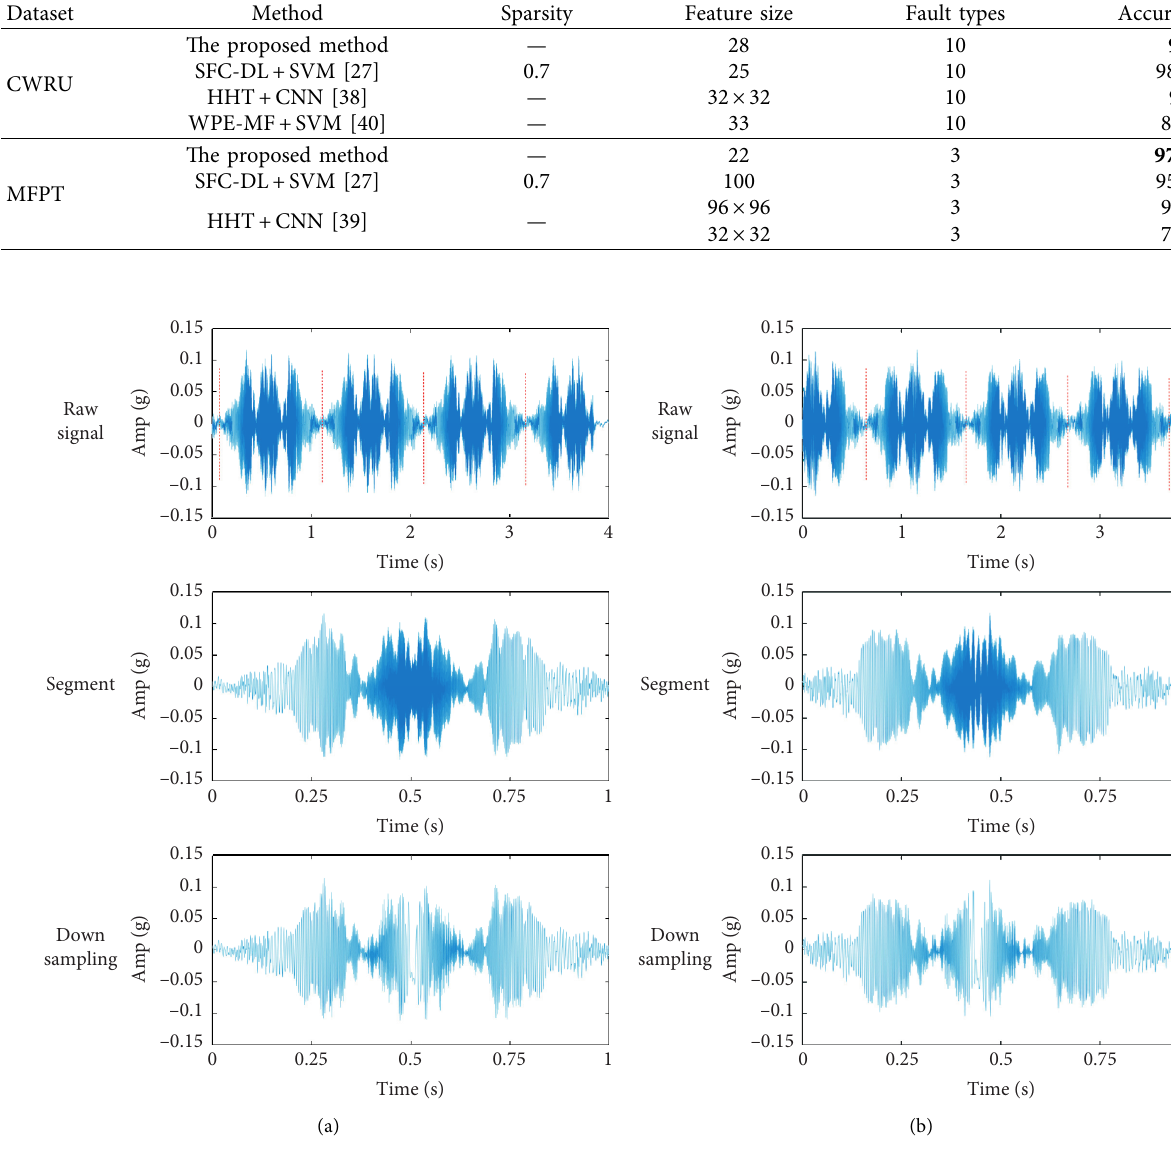
Figure 8: Time-domain waveform of loudspeaker signals: (a) normal; (b)